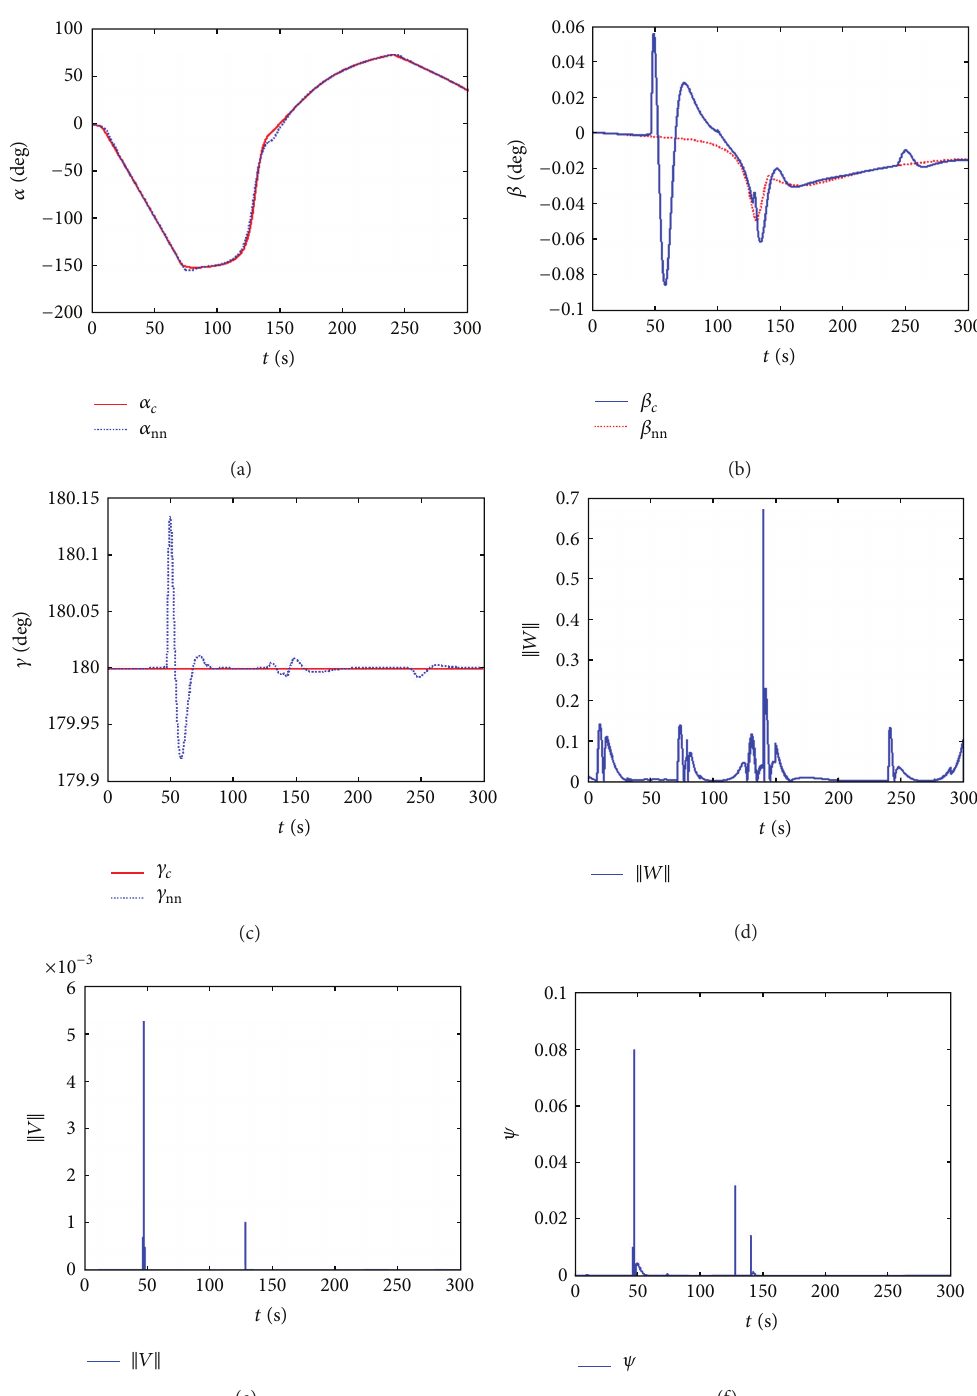
Figure 8: The simulation curve of the whole flight based on the neural network robust adaptive inversion